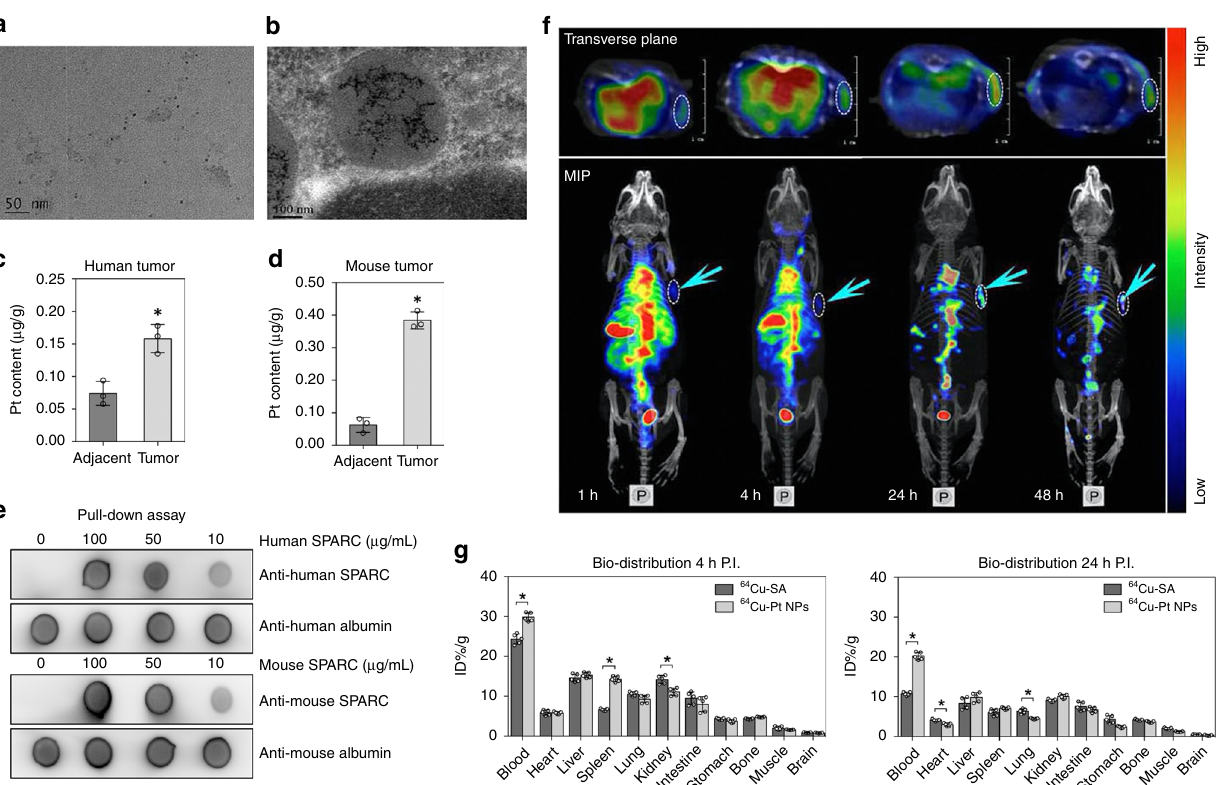
Fig. 4 Tumor targeting and bio-distribution of Pt NPs in vivo. a Representative TEM image of Pt NPs in a human tumor homogenate. b 120 kV bio-TEM showing accumulated Pt NPs in a tumor cell from resected patient tumor tissue. c Quanti fi cation of the Pt NPs in a human tumor and adjacent, normal tissue ( n = 3). * P < 0.05. d Quanti fi cation of the Pt NPs in a mouse tumor and normal, adjacent tissue ( n = 3). * P < 0.05. e P ull-down assay to evaluate the interaction of Pt NPs with SPARC. For human-derived Pt NPs, the Pt NPs were incubated with human SPARC proteins at different concentrations, followed by ultra-centrifugal separation. The SPARC-Pt NP complexes were then subjected to dot blot analysis using an anti-human SPARC antibody. An anti-human albumin antibody was applied as the loading control. For mouse-derived Pt NPs, the same experiment was performed, using a mouse-speci fi c SPARC protein and antibody. f NanoScan SPECT/CT imaging of 125 I-Pt NPs in DNR-resistant K562 cell-xenografted nude mice ( n = 5) at 1, 4, 24 and 48 h after intravenous injection of the NPs. The arrows and dotted circles indicate the tumors. MIP: Maximum Intensity Projection. g Time-dependent bio-distribution of 64 Cu-SA and 64 Cu-Pt NPs in C57BL/6 mice. The results are presented as the percentage injected dose g − 1 of tissue (% ID g − 1 ). The bars in the histogram represent the results from fi ve independent experiments. * P < 0.05. Data = Mean±Standard